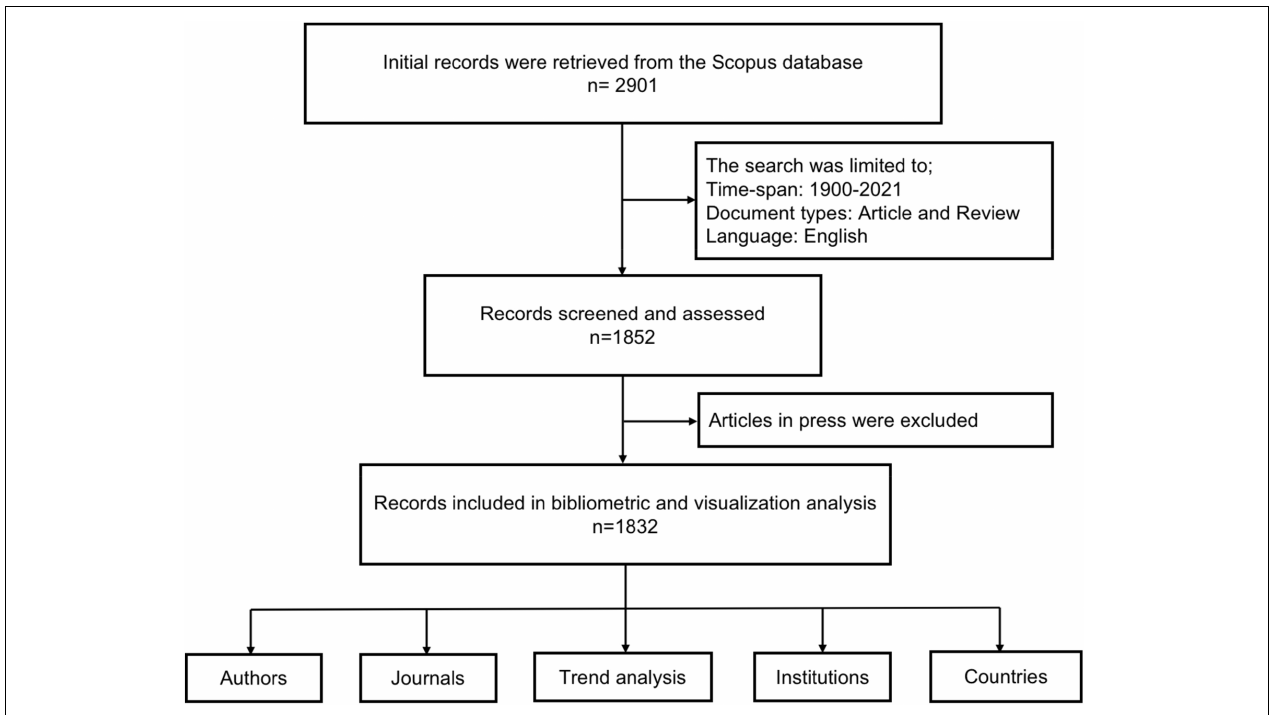
FIGURE 1 | Flow diagram of the included